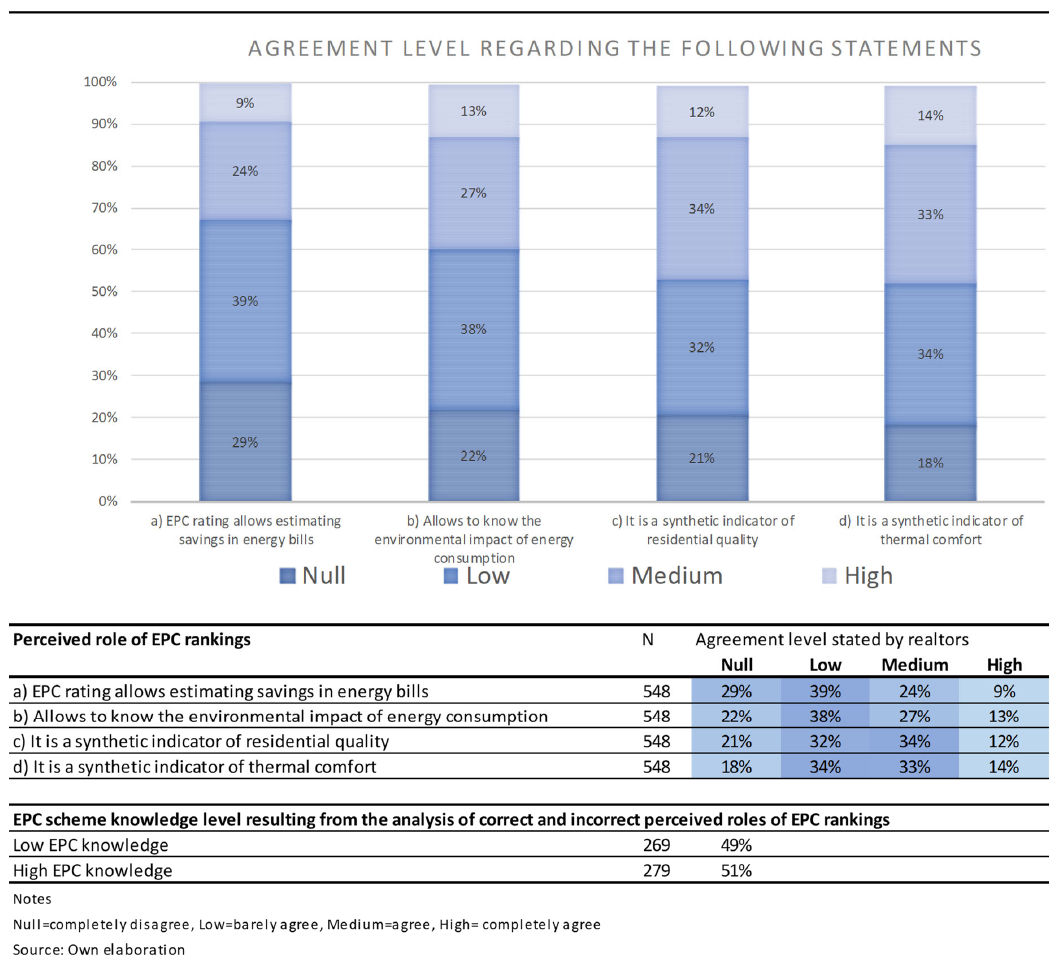
Figure 1. Realtors’ perceptions and knowledge of EPC ratings.